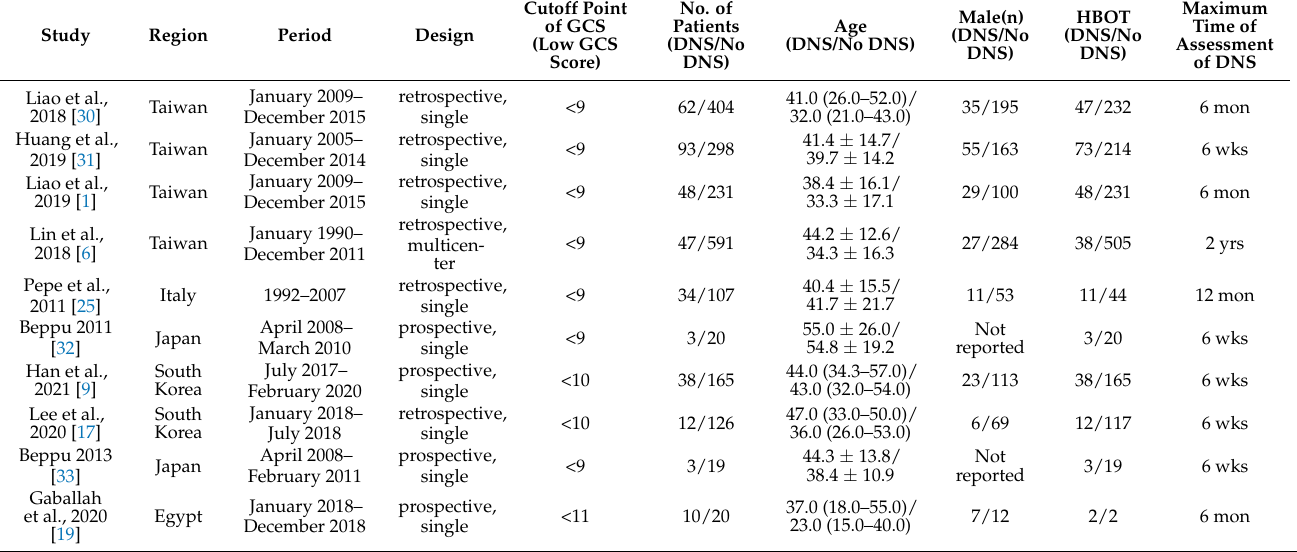
Table 1. Characteristics of studies included in systematic review and